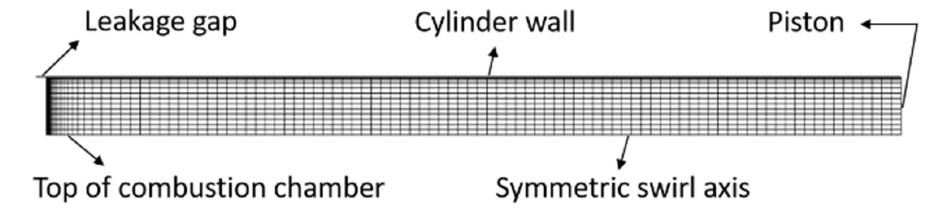
Figure 2. Grid of the micro ‐ HCCI free ‐ piston engine